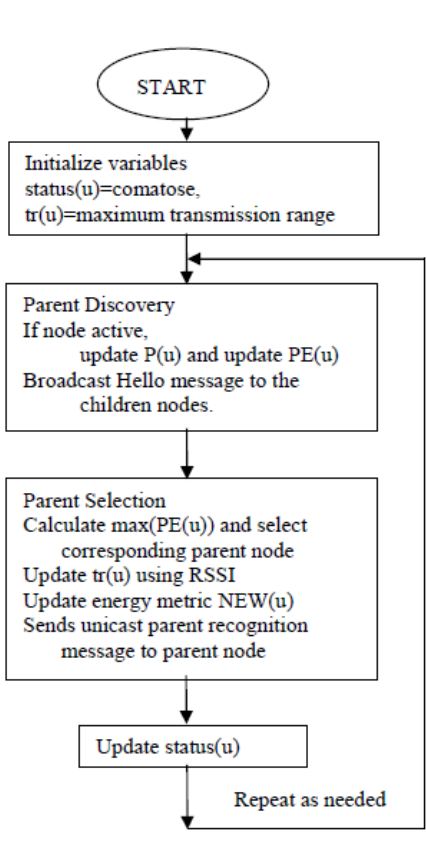
Fig. 3. EAST topology control algorithm